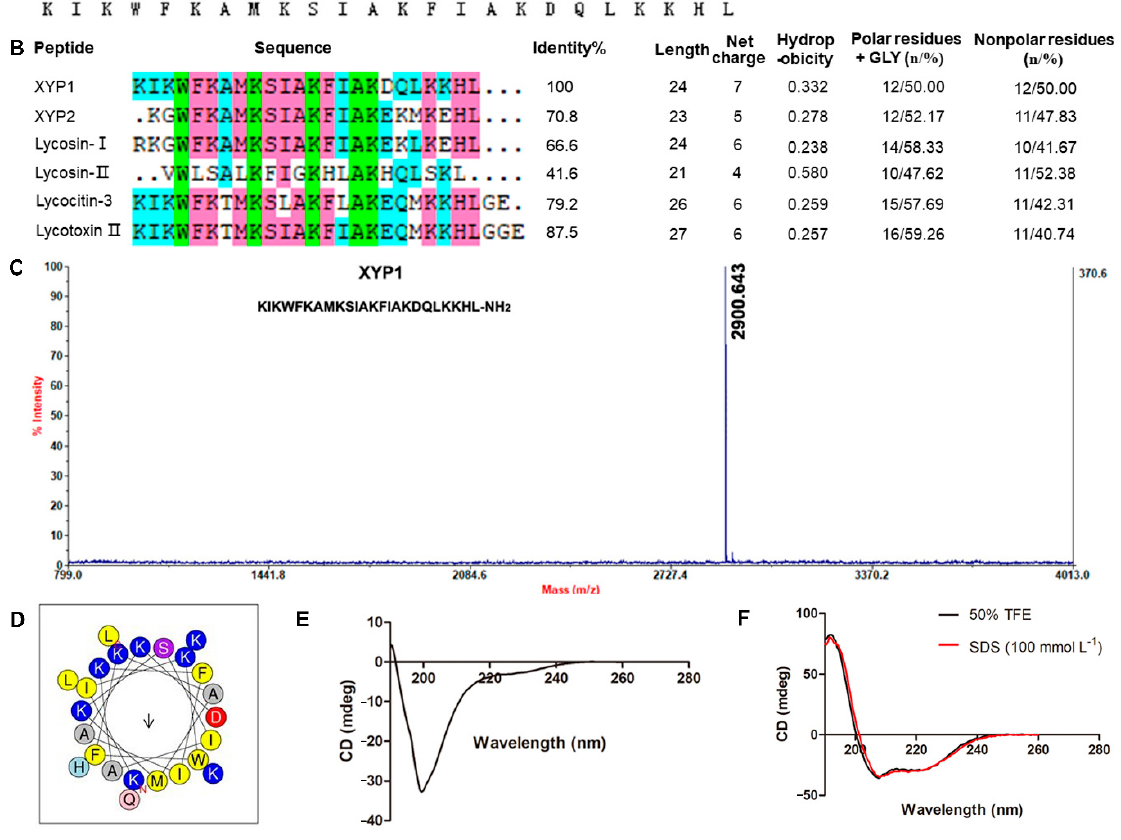
Figure 1. Structure characteristics of XYP1. ( A ) The cDNA sequence and amino acid sequence of XYP1. ( B ) Sequence alignment and physicochemical properties of XYP1 and its analogs. ( C ) Mass spectra of XYP1. The calculated molecular weight of XYP1 was 2901.64 Da and the measured molecular weight was 2900.643 Da. ( D ) Helical wheel projection diagrams of XYP1. The hydrophobic residues are presented in yellow color, positively charged hydrophilic residues blue, the noncharged polar residue purple, and negatively charged hydrophilic residue red. The circular dichroism spectra of XYP1: in PBS (pH 7.4) ( E ) and in the presence of 50% TFE or SDS (100 mmol L − 1 ) ( F ) at 25 °C.